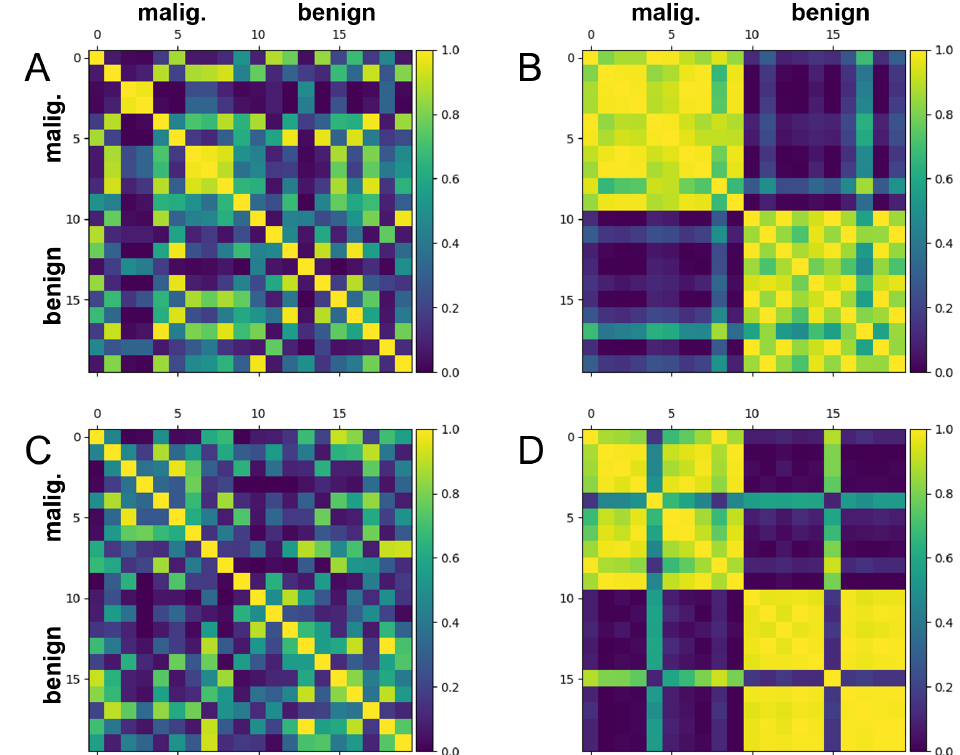
Figure 4. Gram matrices depicting mutual data overlap in Hilbert space (i.e., | (cid:104) x | x (cid:48) (cid:105) | 2 ) for 10 benign and malignant train and test samples from the breast cancer dataset. In each case, 30 starting features (corresponding to 60 trainable linear parameters) were used, with no subsequent PCA feature reduction. The stronger the separation between the purple tiles (benign) and the yellow tiles (malignant), the better the model’s ability to classify. A random seed of ’1’ was used for the train-test split of this data. The PennyLane software package was used to train the embedding [40]. ( A ) Mutual data overlap in Hilbert space for training set datapoints at optimization step 0. ( B ) Mutual data overlap in Hilbert space for training set datapoints at optimization step 1500. ( C ) Mutual data overlap in Hilbert space for test set datapoints at optimization step 0. ( D ) Mutual data overlap in Hilbert space for test set datapoints at optimization step